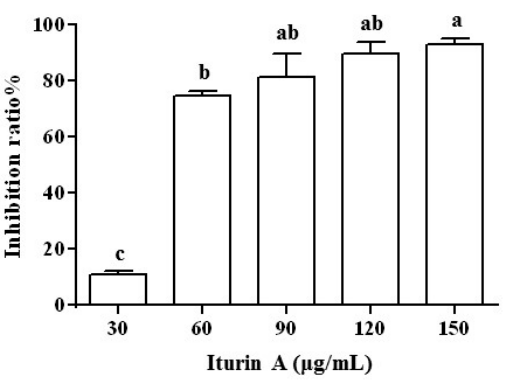
Figure 2. Effect of iturin A at different concentrations on the dry weight of FON mycelia. Different lowercase letters indicate significant differences ( p < 0.05).